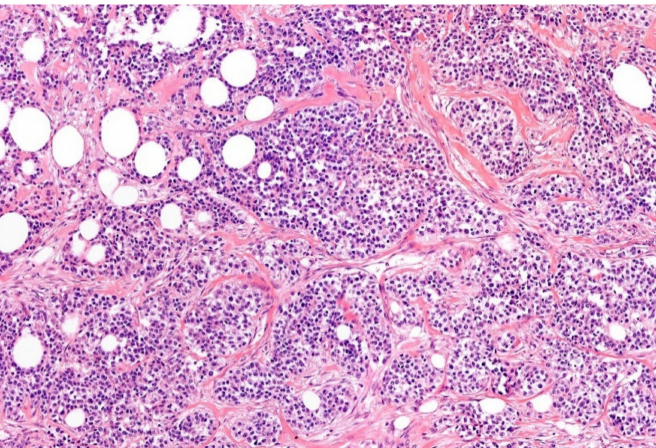
Figure 8. Clear-cell sarcoma comprises of nests of epithelioid cells separated by fibrous septa. There are uniform round nuclei and eosinophilic to clear cytoplasm (HE; 20 ×